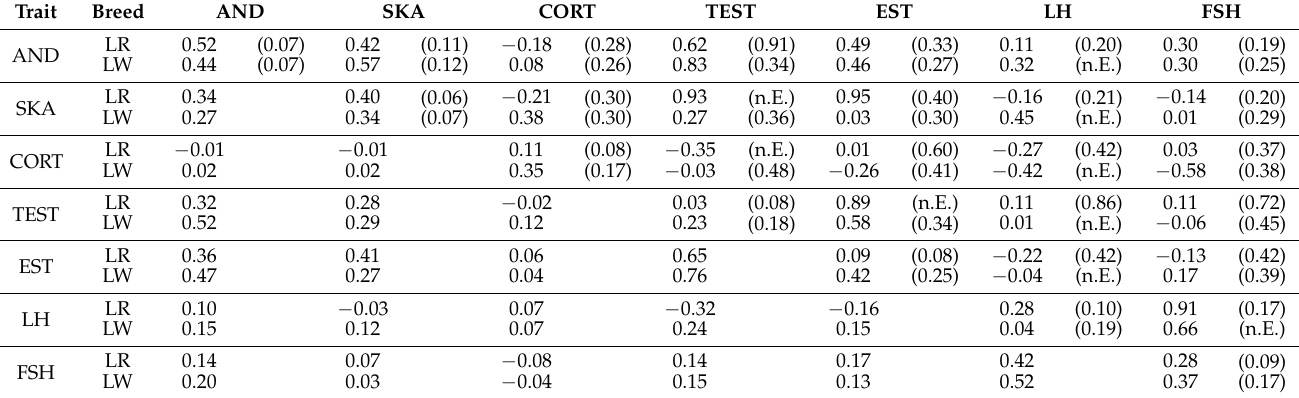
Table 3. h 2 , r g and r p of boar taint compounds and hormone concentrations in Landrace (LR) and Large White (LW).